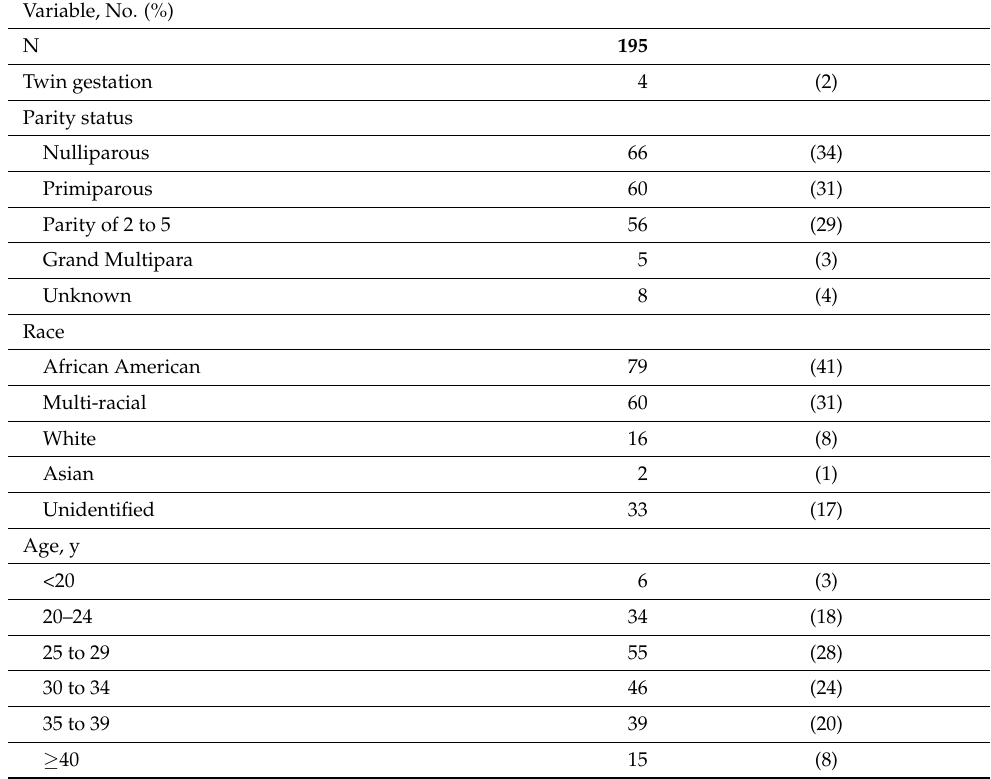
Table 1. Baseline characteristics of low-risk pregnant women who underwent echocardiography. Variable, No.